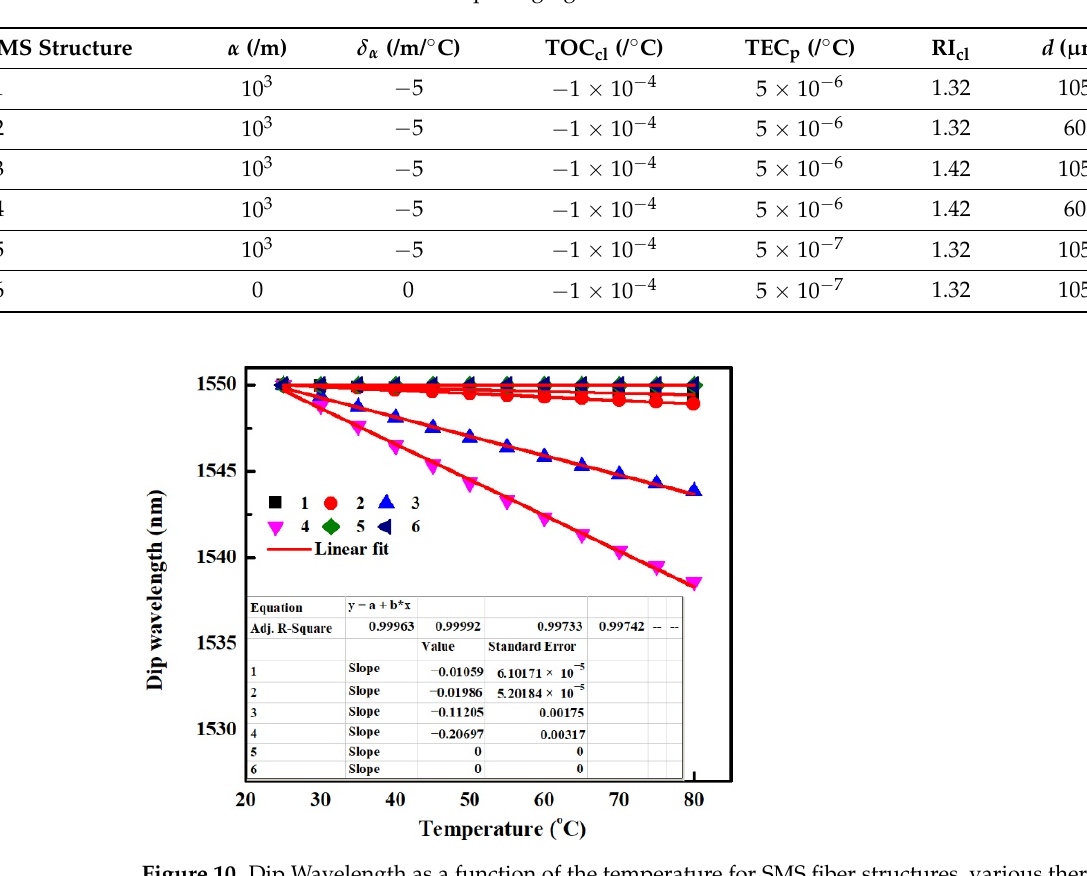
Table 5. Parameters of MMF and packaging shell in the SMS fiber structure.